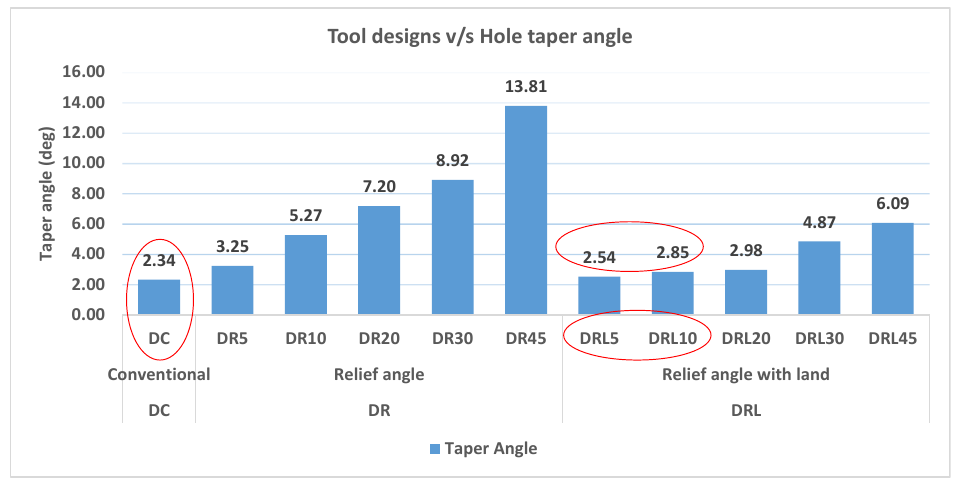
Figure 5. Effect of electrode designs on taper angle of machined hole. Figure 5. E ff ect of electrode designs on taper angle of machined